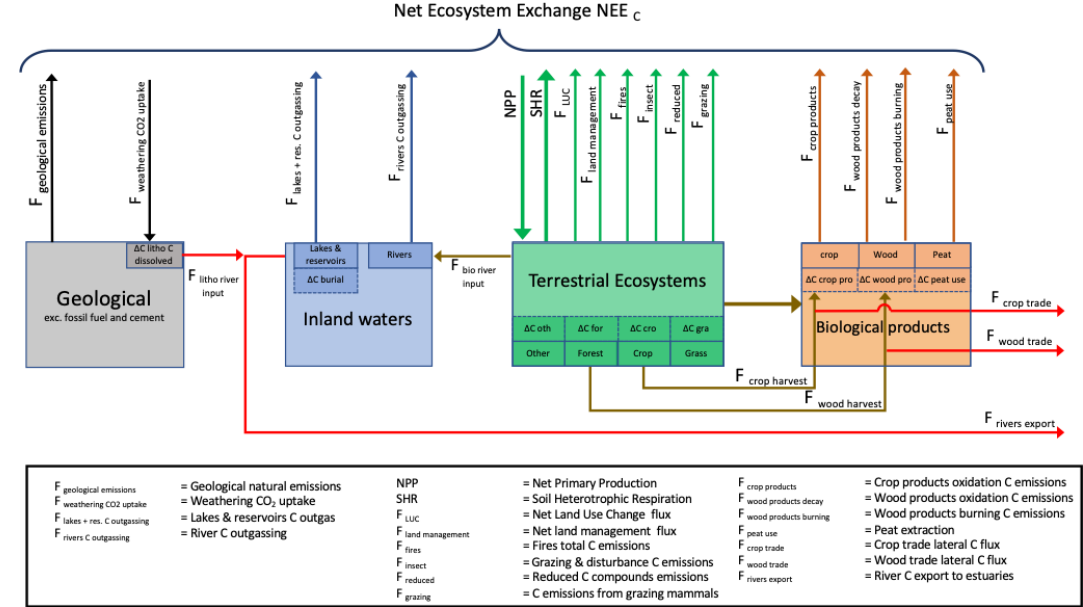
Figure 2. Summary of C fluxes to be reported in each RECCAP2 region (top) and the name of each flux